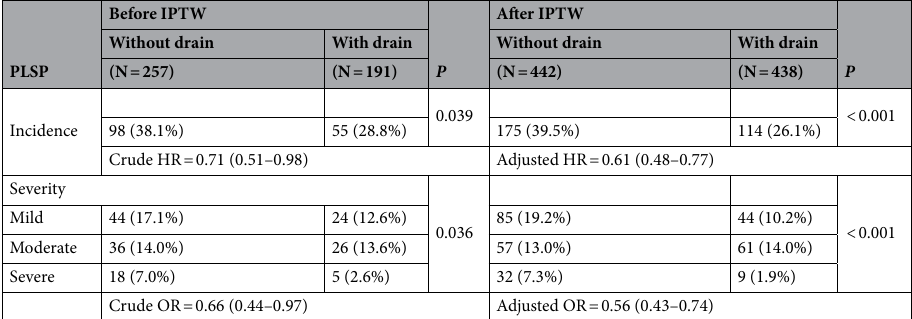
Table 2. Comparisons of the incidence and severity of PLSP between the groups with drain and the other without drain before and after IPTW adjustment. Data are exhibited as count (%). IPTW inverse probability of treatment weighting, HR hazard ratio, OR odds ratio, HR and OR are estimated using Cox and Ordinal logistic regression models, respectively, and presented in their estimated values (95% CI).